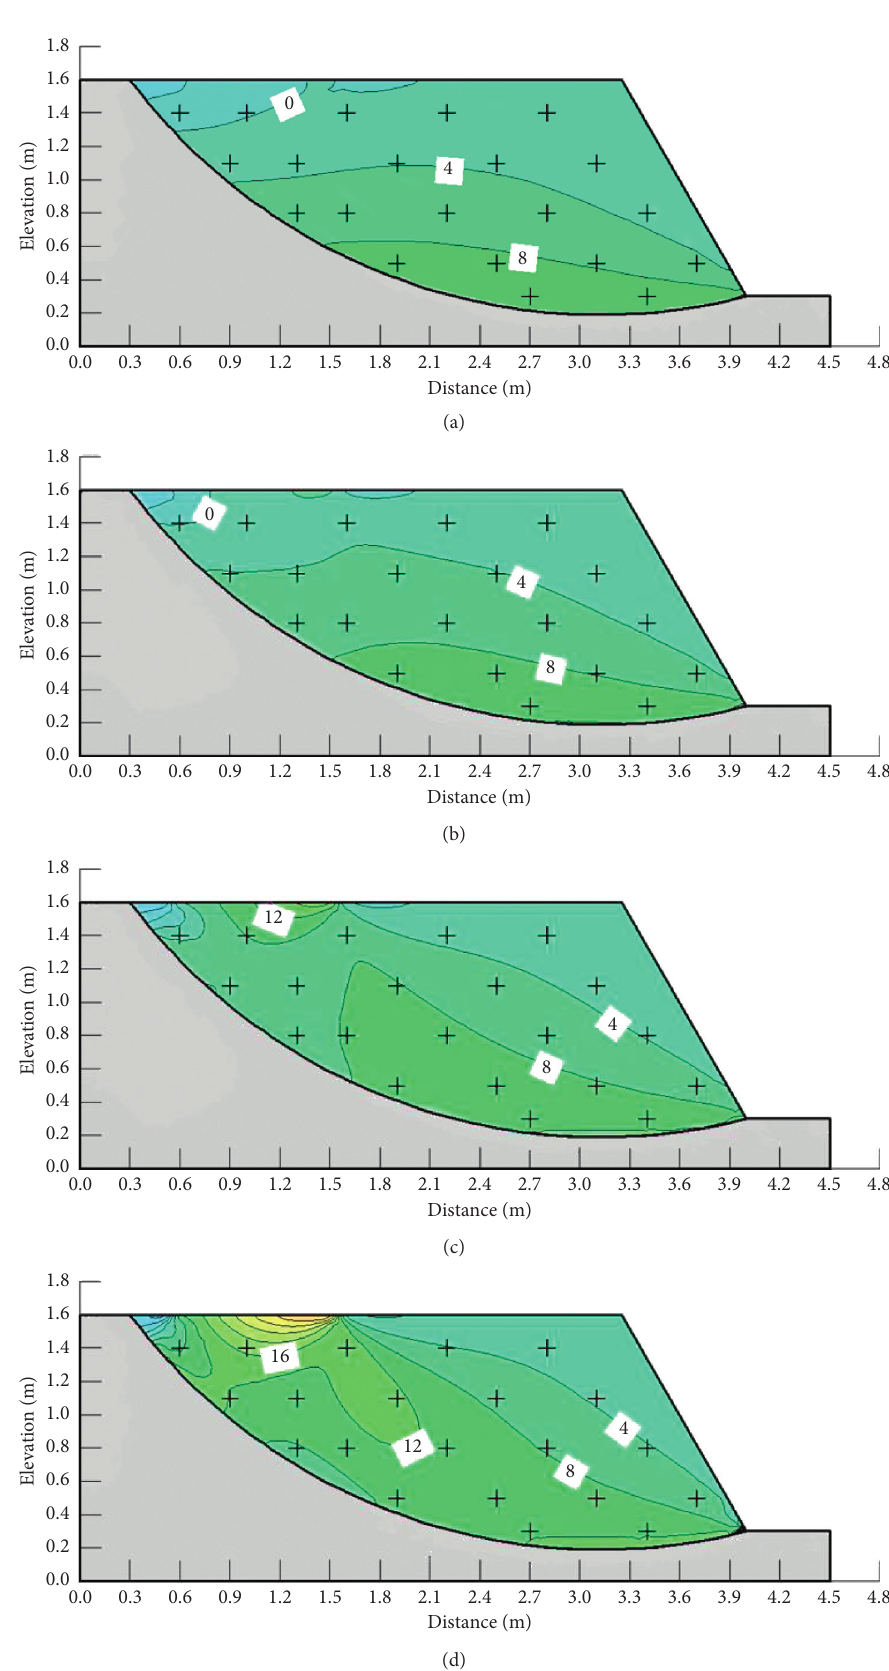
Figure 12: Typical horizontal stress contours during loading process (unit of isoline label: kPa). Loading to (a) 5kN, (b) 20kN, (c) 60kN, and (d)